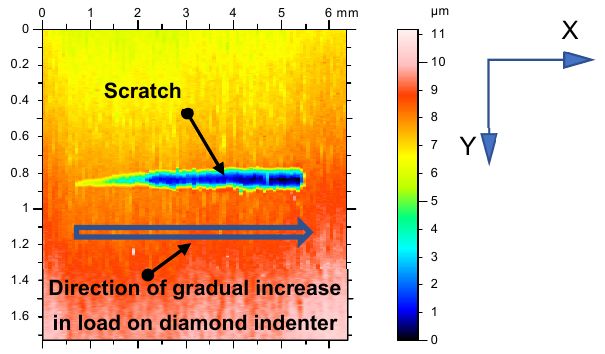
Figure 2. Image of scratch caused by gradual increase in load on diamond indenter (top view: load increase from left to right). Scratch test parameters, proposed as a standard [6], were selected on the basis of the results of previous comprehensive studies investigating different types of coating materi- als and substrates for the cutting blade (1200 Rockwell diamond indenter). They were as dL/dx = 40 N·mm − 1 ; diamond indenter radius R = 0.20 mm. These parameters ensured